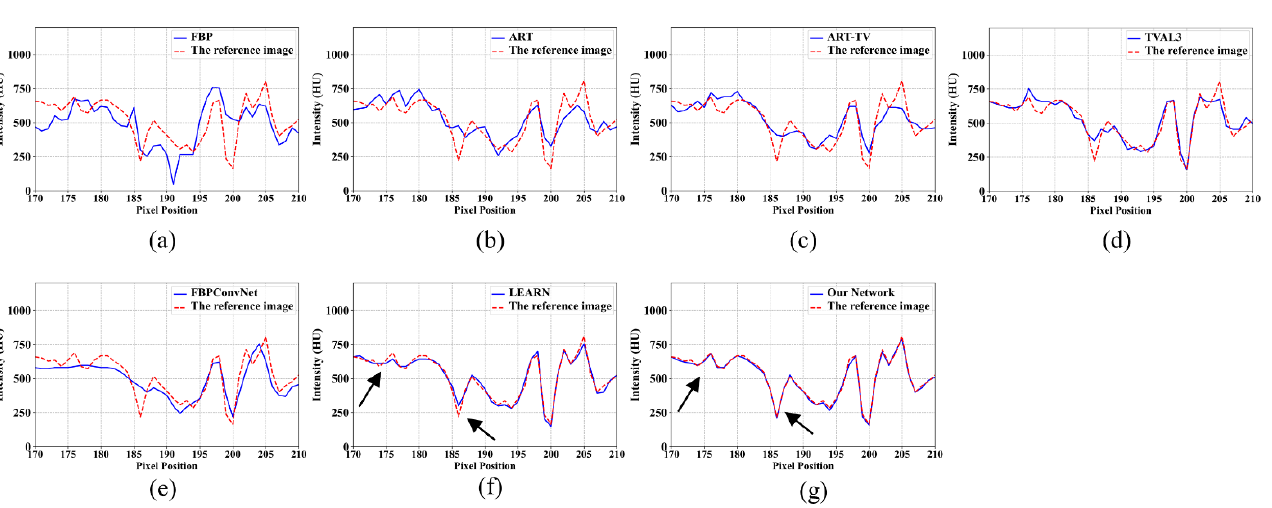
11 of 18 Figure 5. Images reconstructed (from 64 views) using various methods. ( a ) The reference image versus the images reconstructed using ( b ) FBP, ( c ) ART, ( d ) ART-TV, ( e ) TVAL3, ( f ) FBPConvNet, ( g ) LEARN, and ( h ) our network. The profiles along the blue line are shown in Figure 6. The red box indicates the ROI, which is magnified. The display window is [0, 1100] HUs in size. For the reconstruction results from 128 views, the results of each algorithm have been significantly improved as shown in Figure 7. Only the result of the FBP method contains